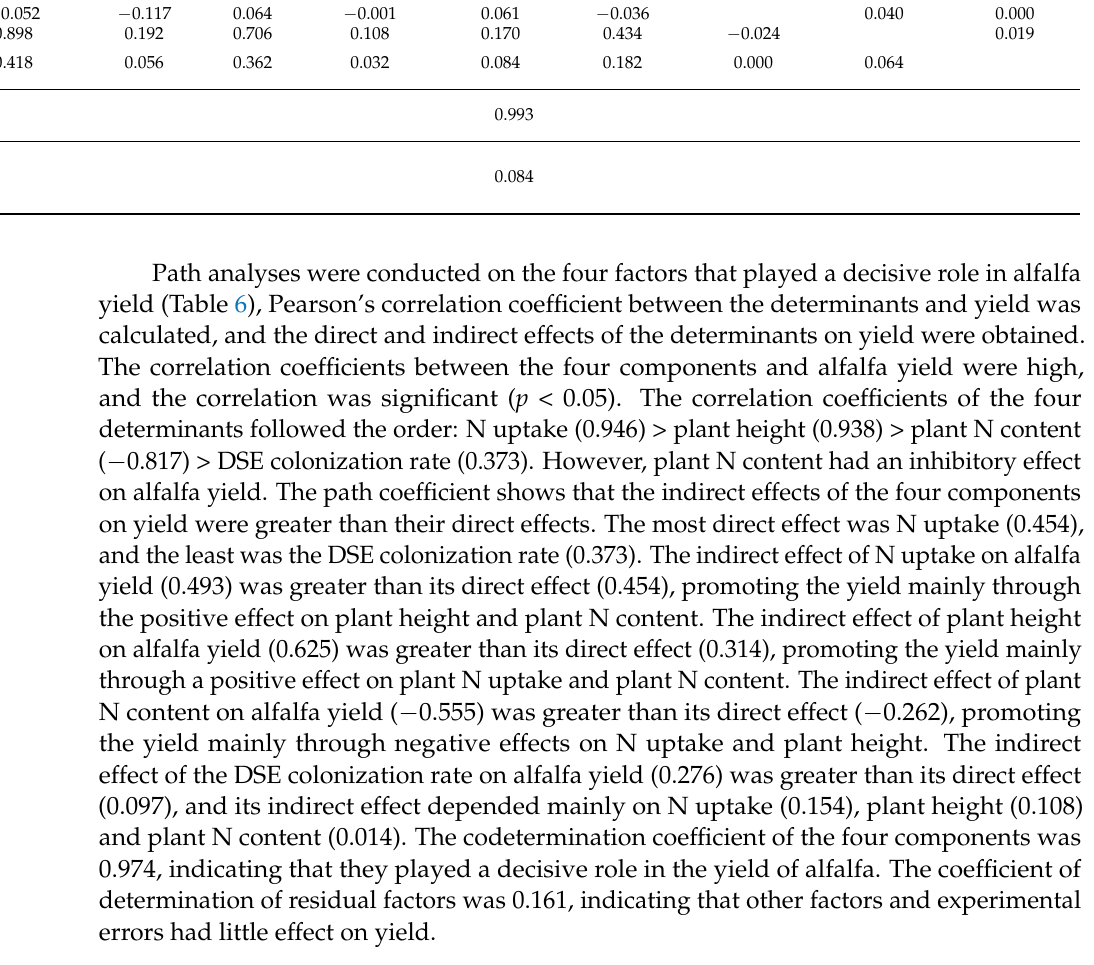
Table 6. Path analysis of yield determinants of